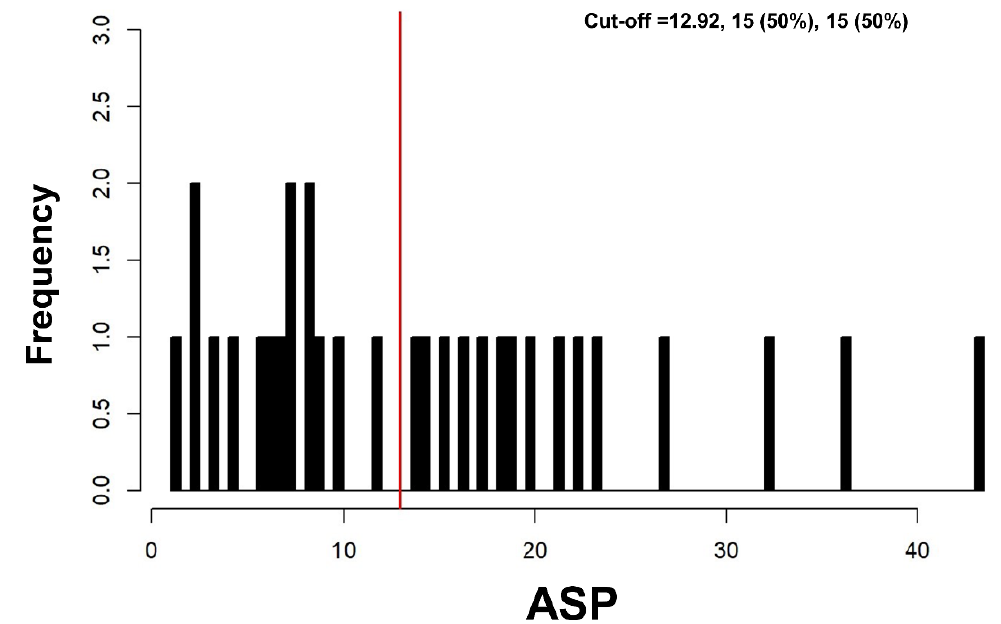
Figure 4. Histogram—Cut-off finder for asphericity (ASP). Histogram showing the distribution of ASP among all 30 patients. The vertical line (red) highlights the optimal cut-off at 12.9%.